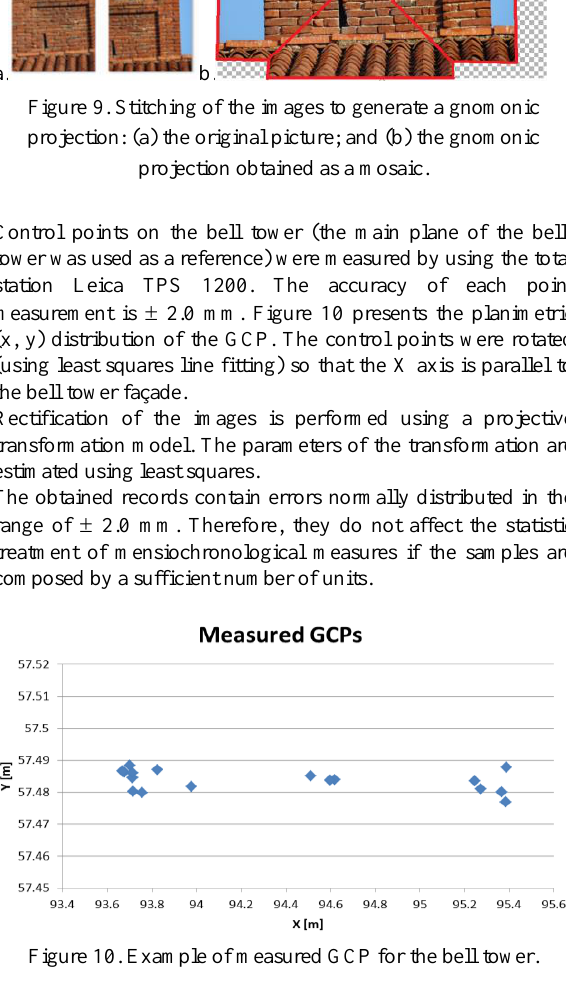
Figure 11. Rectified picture of the east side of the Sanctuary bell tower with two considered areas used for the direct (at 1.20m) and indirect (at 7.50m) measurements.